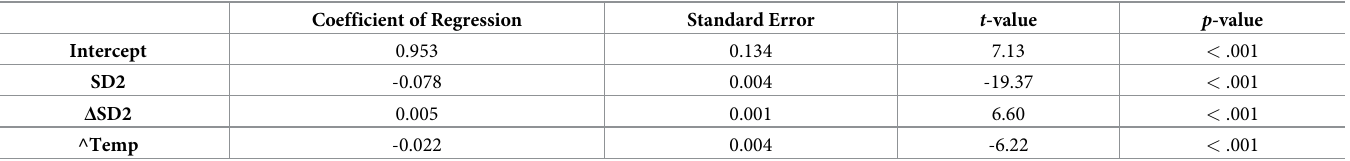
Table 3. Multiple regression analysis results.